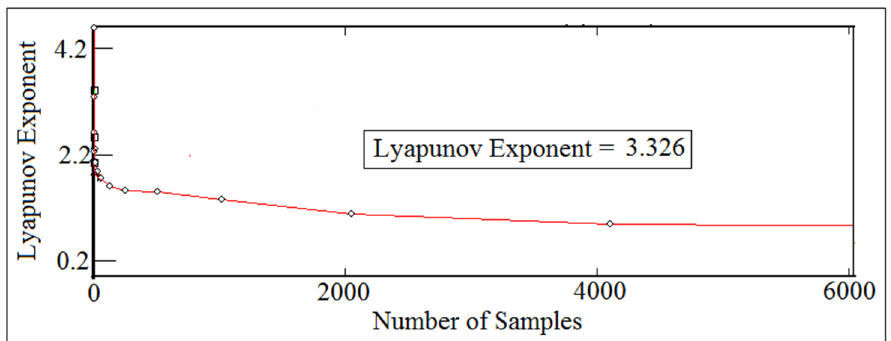
Figure 45. Local Lyapunov exponent against number of samples for (I.D. = 18 mm) and (N = 800 rpm).